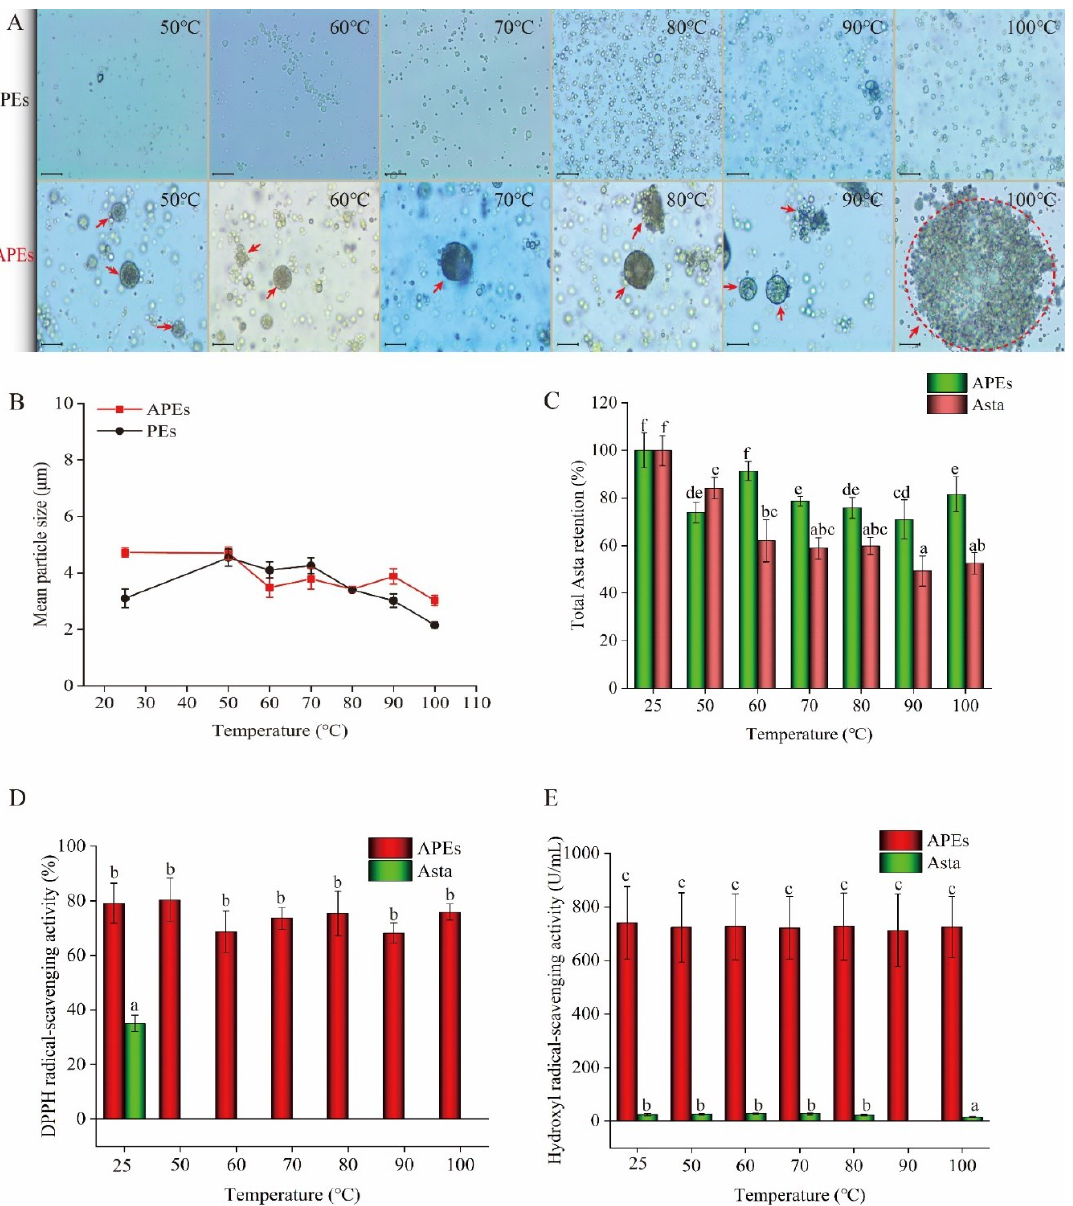
Figure 4. Thermal stability of APEs after 30 min of treatment at 25 °C to 100 °C. PEs or bare Asta was used as comparison. ( A ) optical micrograph changes of APEs, scale at 400 times magnification, ( B ) mean particle size of APEs, ( C ) total Asta retention rate in APEs as compared to bare Asta, ( D ) DPPH radical-scavenging activity of APEs compared with bare Asta, and ( E ) hydroxyl radical-scavenging activity of APEs compared with bare Asta. Data were expressed as the mean ± standard deviation ( n = 3). Different lower-case letters on the bars in ( C – E ) indicate significant differences ( p < 0.05).